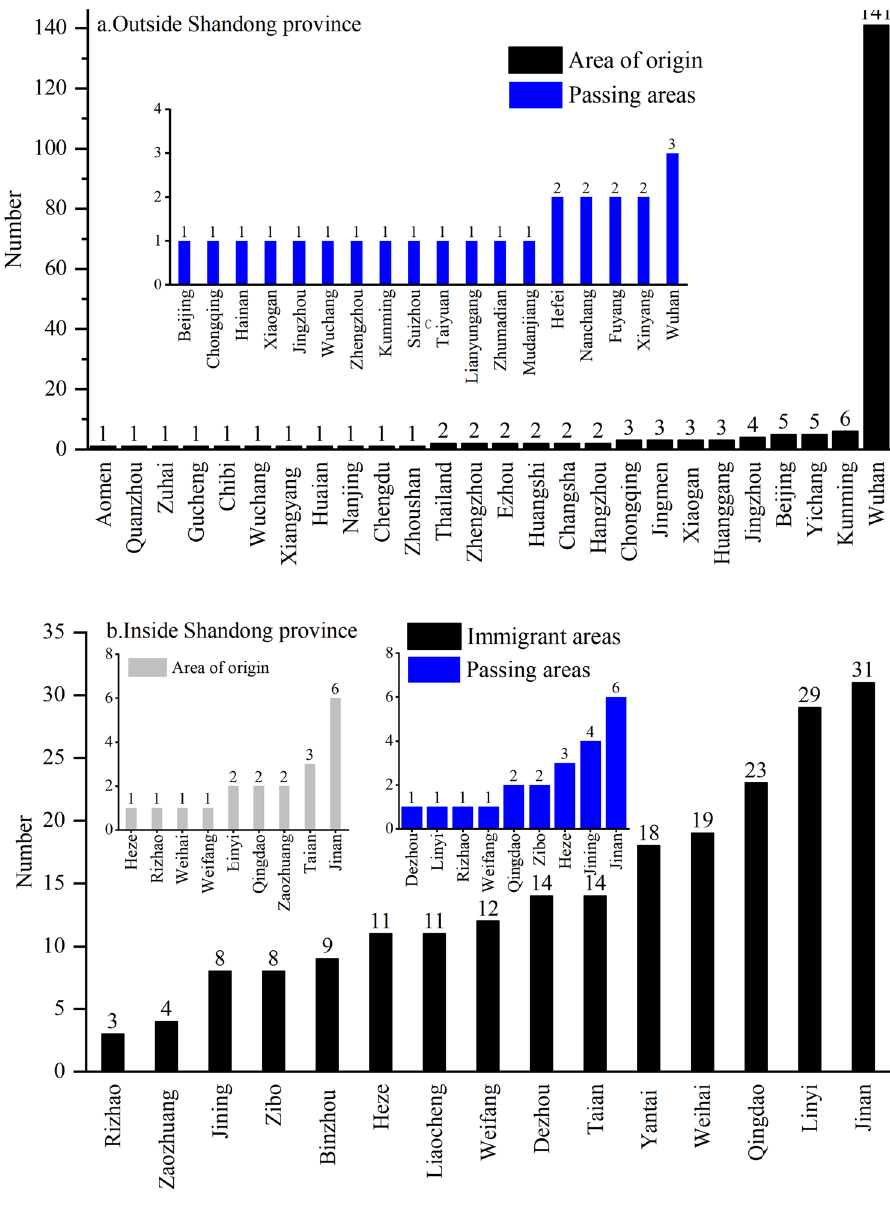
Figure 11. Distribution of migration track points of confirmed COVID-19 cases in Shandong